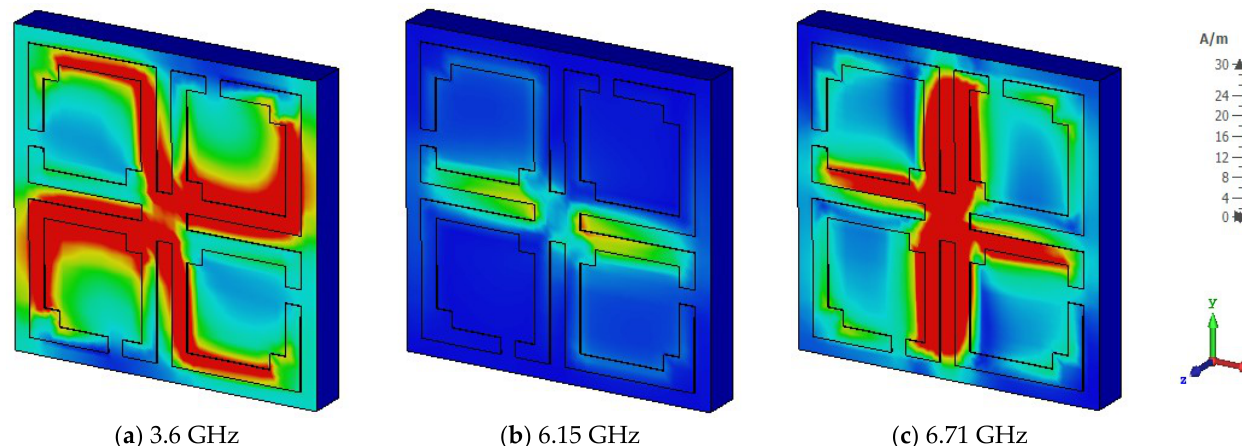
Figure 7. Distributions of the magnetic field at the three distinct resonance frequencies.